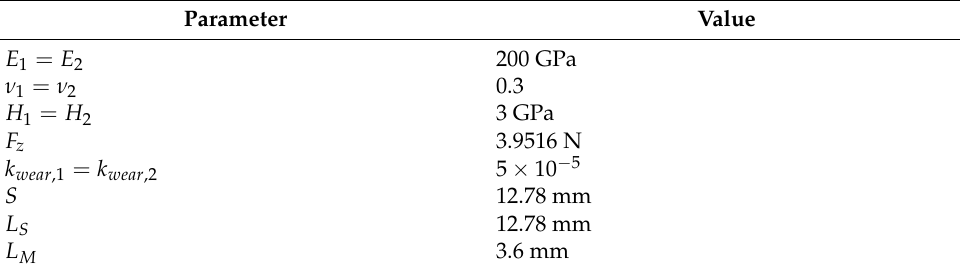
Table 2. Contact and wear analysis